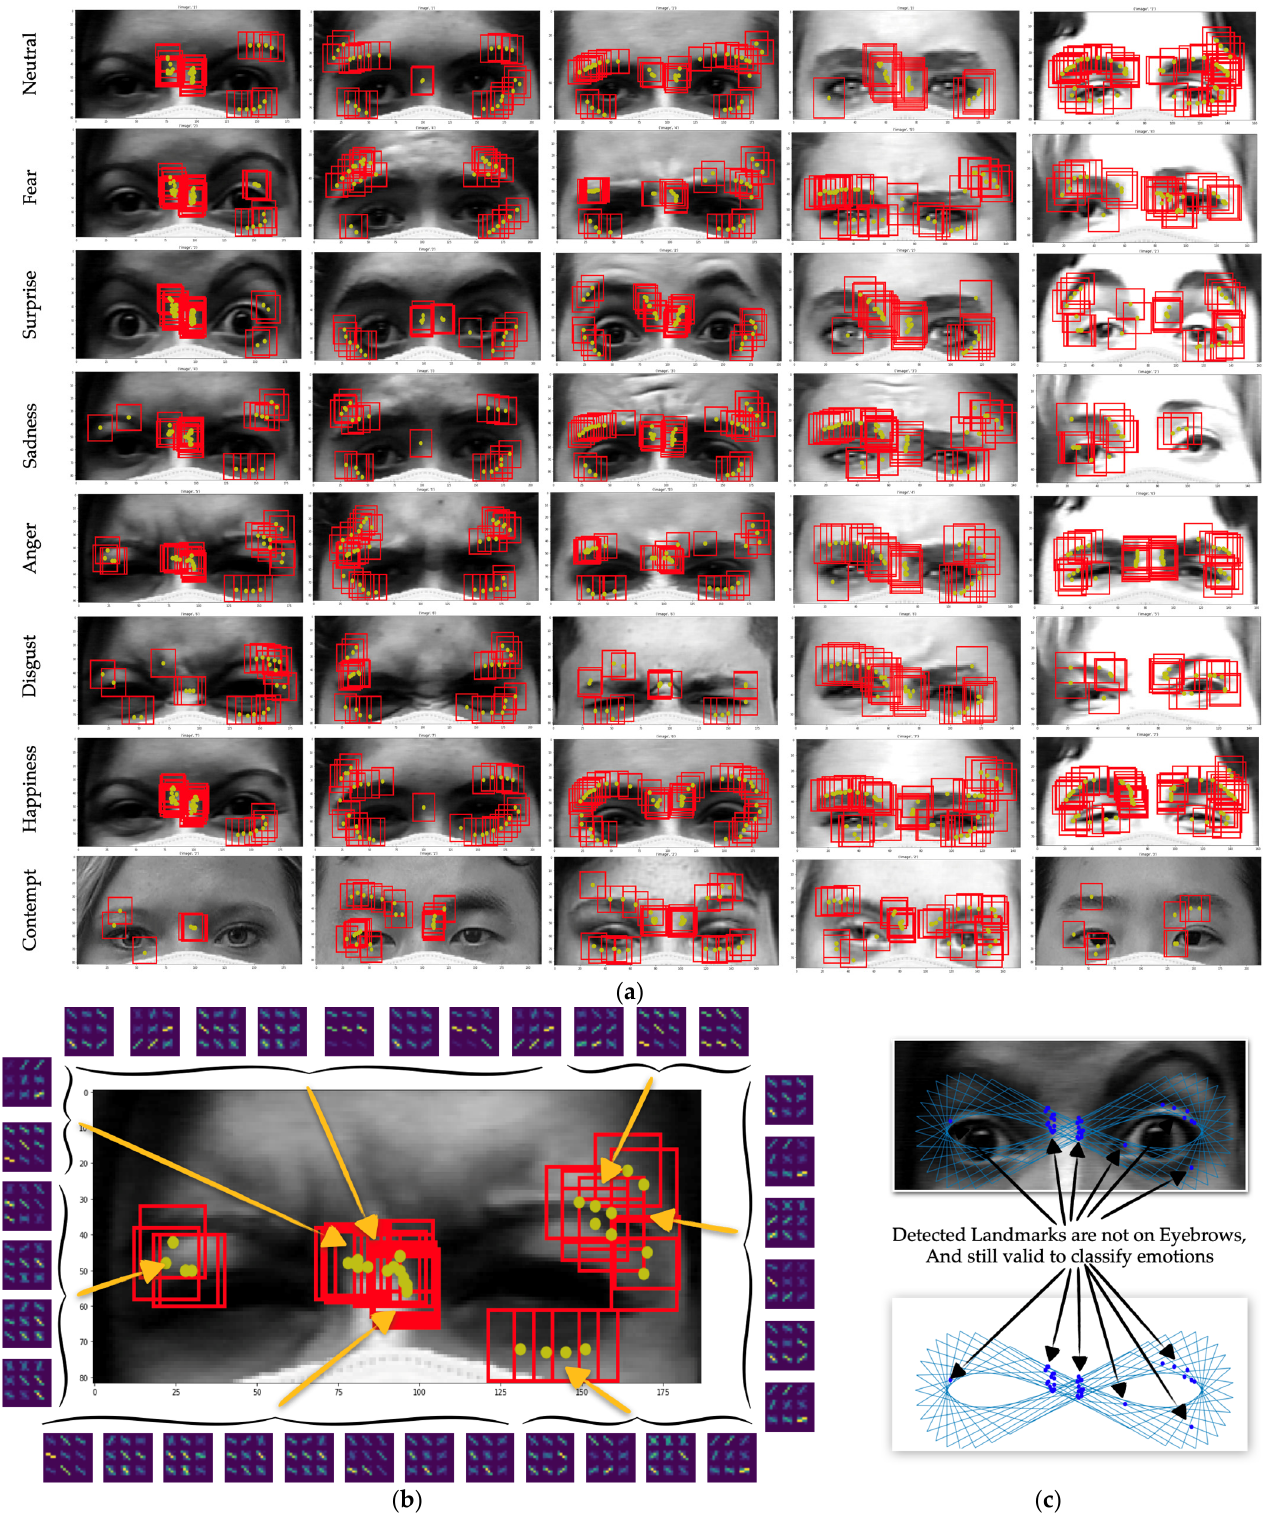
Figure 15. All of the detected landmarks for eight emotions in the CK+ data set; ( a ) images of upper faces with the infinity shape and detected landmarks; ( b ) detected landmarks; ( c ) detected landmarks that are not on the eyebrows.